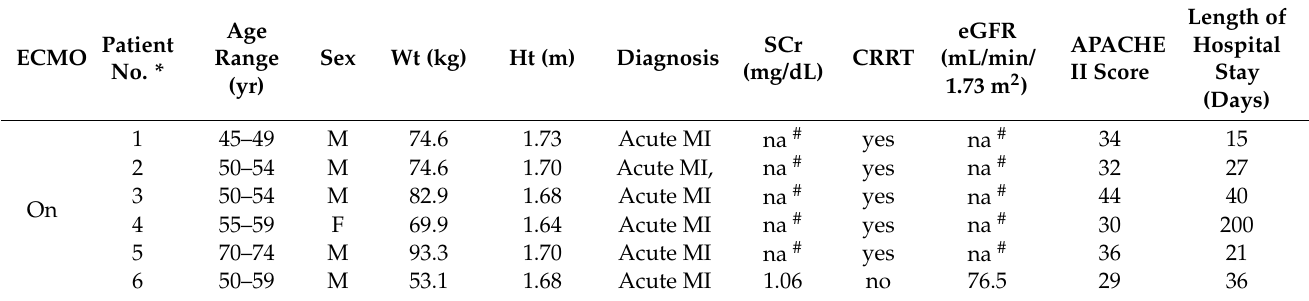
Table 1. Demographic information and baseline characteristics of all enrolled